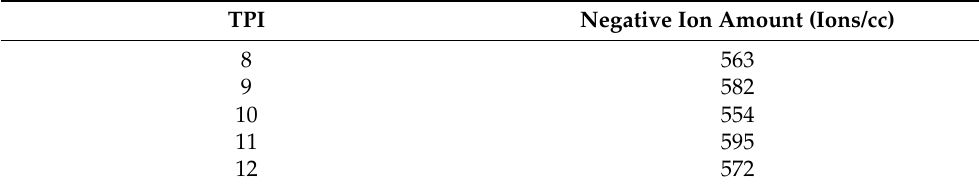
Figure 11. The release amount of negative ions of non-woven fabrics composed of the Ge/SS core-spun yarns. Table 5. Release amount of negative ions of non-woven